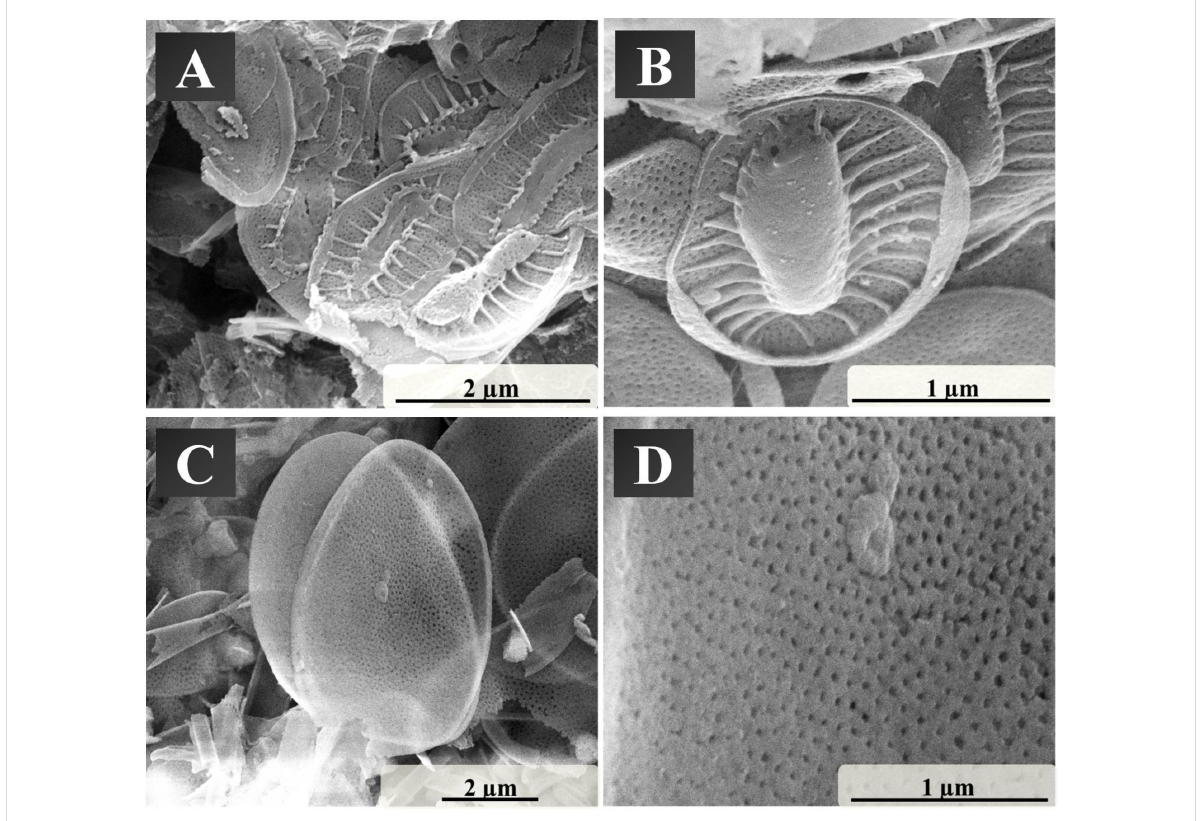
Figure 6: Scanning electron micrographs of the skeletons of Synura petersenii (A, B) and the shields of Mallomonas caudata (C, D) after conversion to silicon.